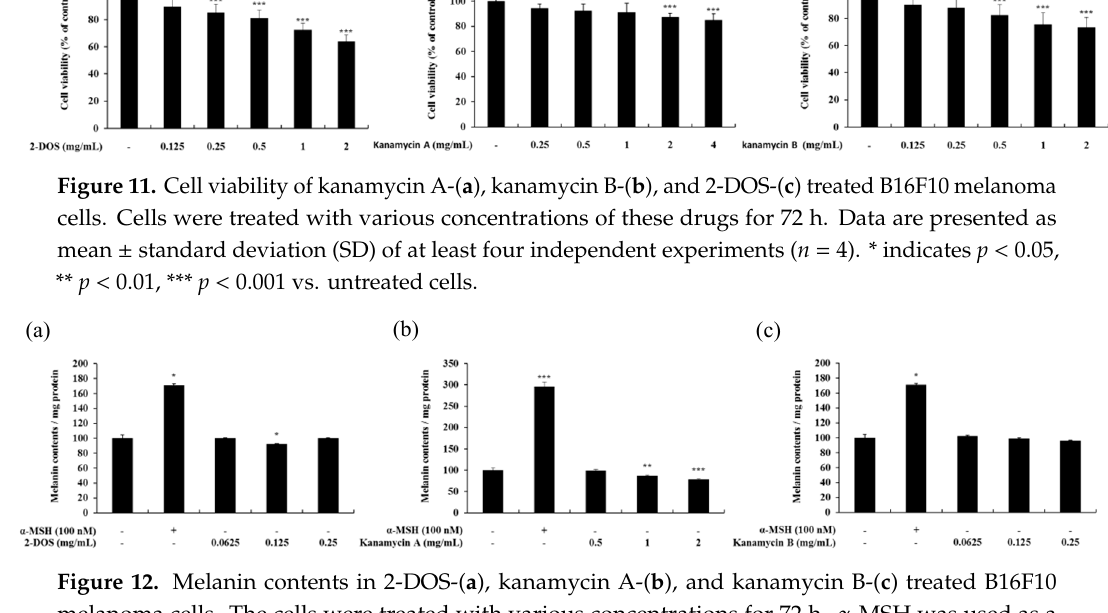
Figure 12. Melanin contents in 2-DOS-( a ), kanamycin A-( b ), and kanamycin B-( c ) treated B16F10 melanoma cells. The cells were treated with various concentrations for 72 h. α -MSH was used as a positive control. Melanin concentrations are expressed as percentages compared to the respective values obtained for the control cells. Data are presented as mean ± standard deviation (SD) of at least four independent experiments ( n = 4). * indicates p < 0.05, ** p < 0.01, *** p < 0.001 vs. untreated cells.